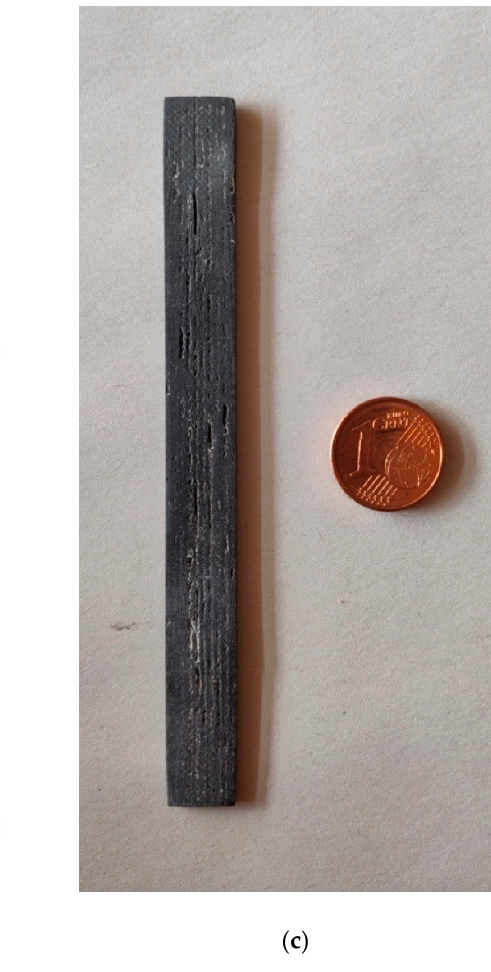
Figure 5. Average stress versus strain graphs with neat resin (Batch 1) as a reference, and specimen image: ( a ) FIL100 (Batch 2) and GAM Fine 3D printable inks (Batch 3), ( b ) GAM Fine 3D Printable inks (Batch 4 and 5), ( c ) GAM Fine 3D printed specimen after manual polishing.